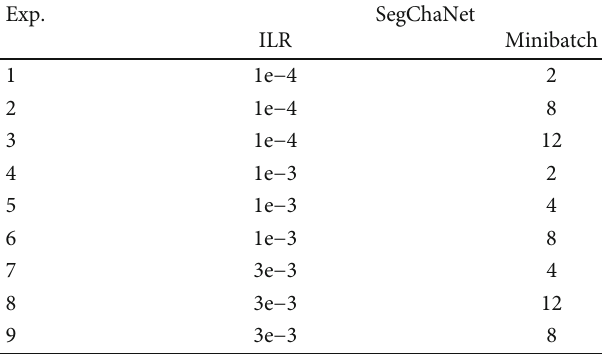
Table 4: Hyperparameters used for training SegChaNet.